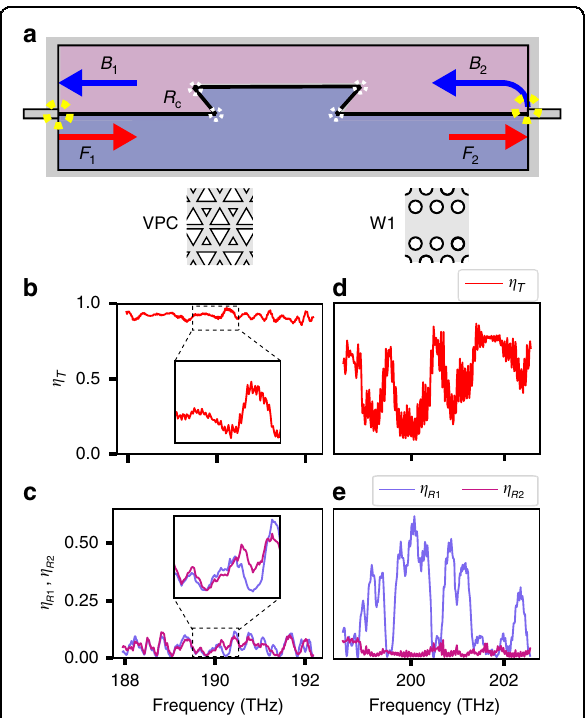
Fig. 3 Directional transport along defects. For the topologically non-trivial VPC waveguide, a shows the schematic of the probed 120° corner. b Top-view SEM image of the fabricated Ω -shaped defect. Two-dimensional real-space amplitude maps showing the c , full mode amplitude distribution, d forward-propagating mode amplitude only, and e backward-propagating mode amplitude only. The amplitude maps are normalized independently to their maximum value. For a topologically trivial W1 waveguide, f schematically shows the mode propagation around a 120° corner, and g shows a top-view SEM image of the device. The two-dimensional amplitude maps of the fi ltered forward- and backward-propagating modes are shown in h and i , respectively. The direction of in-coupling is indicated by the green arrows. All scale bars correspond to 5 μ m